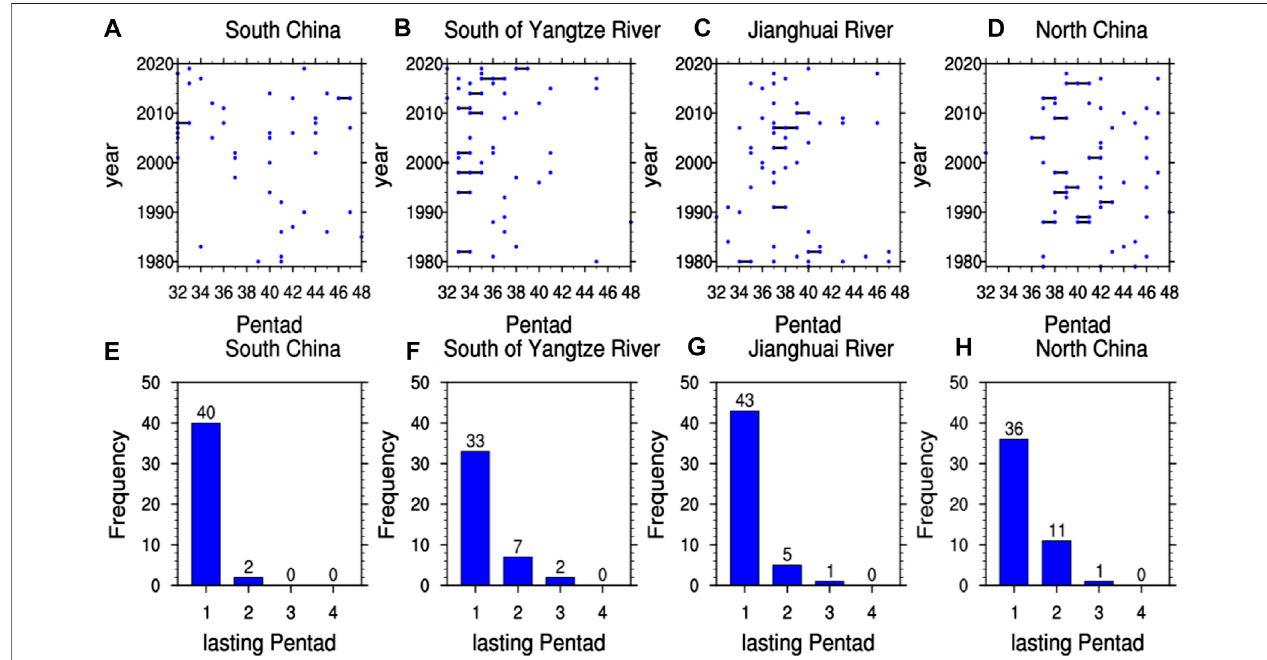
FIGURE5| Theoccurrencetime (A – D) andfrequencyofRPEPwithdifferentlastingpentads (E – H) inSC (A , E) ,SYR (B , F) ,JHR (C , G), andNC (D , H) .In (A – D) ,one blue dot indicates one RPEP, and the black solid line links the consecutive RPEPs.